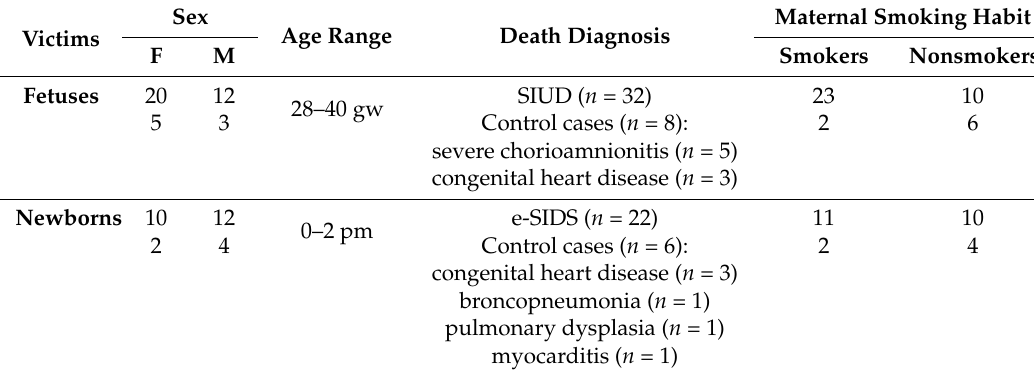
Table 1. Case profiles of the